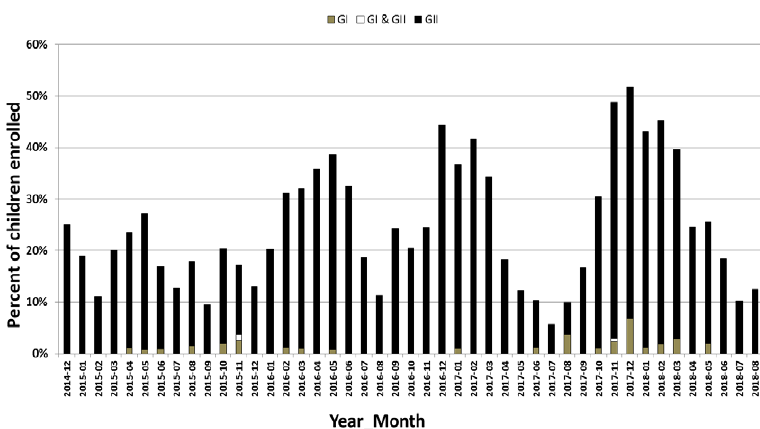
Figure 1. Monthly distribution of norovirus genogroup I and genogroup II in children with AGE from December 2014 to August 2018 in Alberta. The y -axis represents the percent of kids enrolled with AGE and the x -axis represents the month of the year. AGE: acute gastroenteritis. Table 3. Seasonal distribution of Norovirus Genogroups and Genotypes.